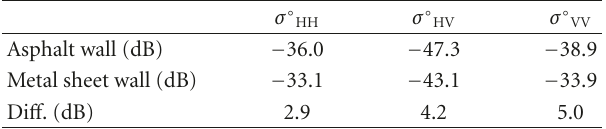
Table 2: σ ◦ derived from double scattering of asphalt wall and metal sheet with